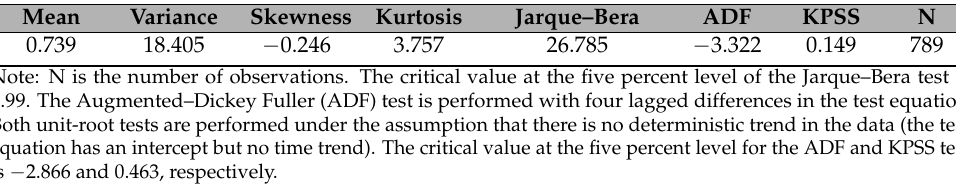
Table A2. Descriptive statistics, Jarque–Bera and unit–root test statistic—real returns.